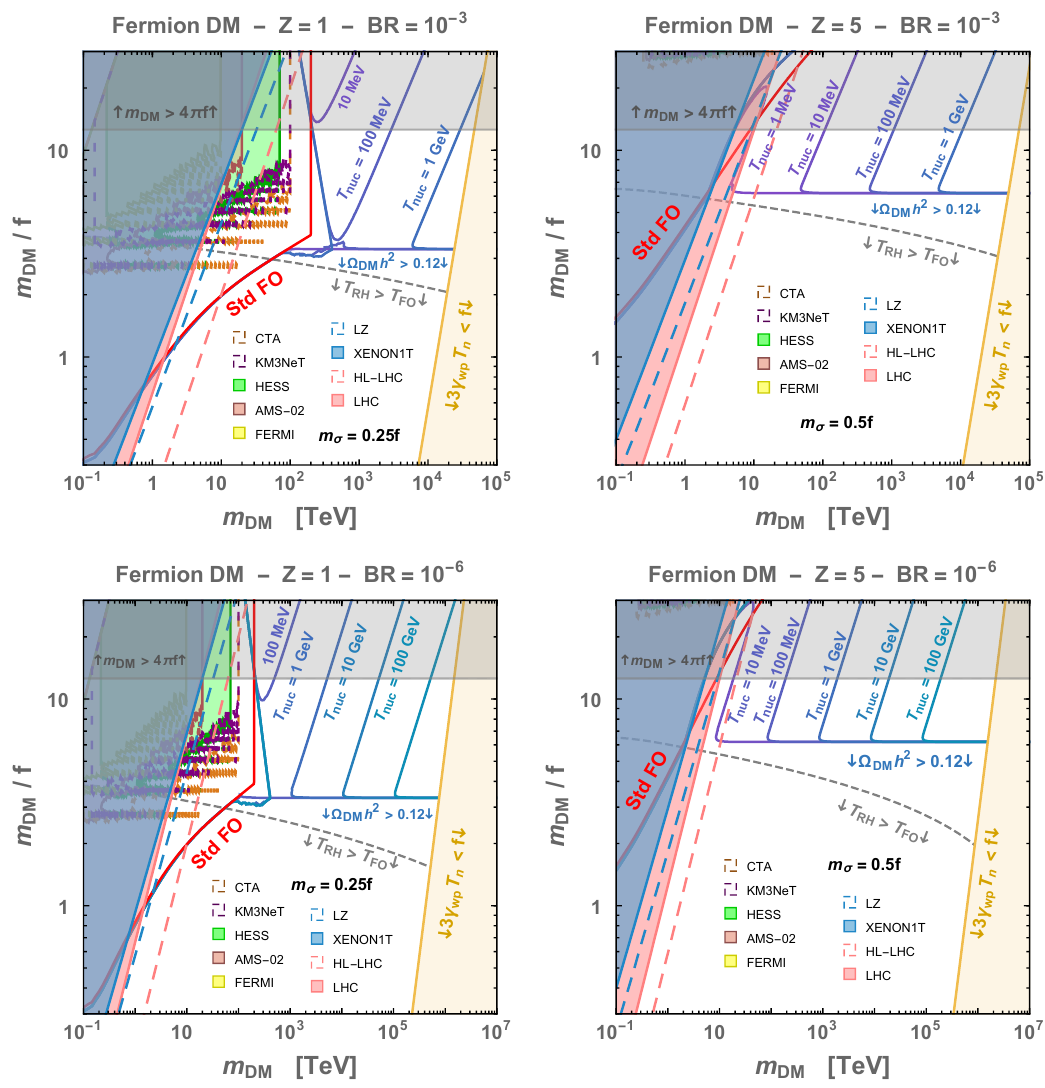
Figure 16 . Supercooled dilaton-mediated fermionic DM. Lines and shadings as in figure 6. The indirect-detection constraints are suppressed compared to the scalar and vector cases, because the annihilation cross-section of fermion DM is p-wave, cf. eq.